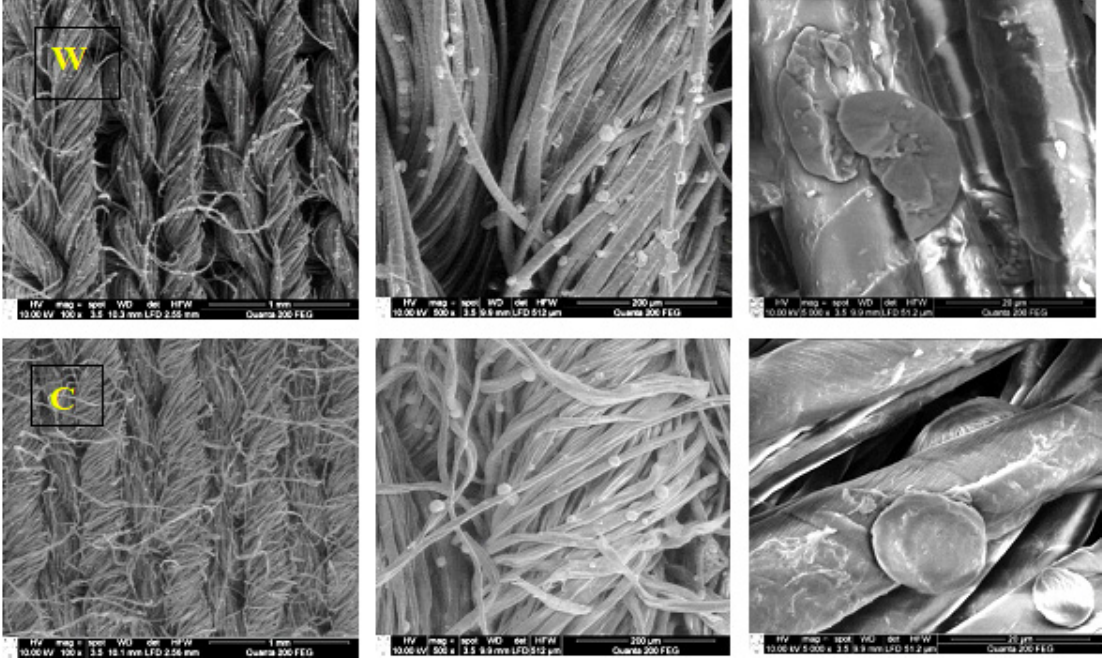
Figure 3. SEM images of W ( top ) and C ( bottom ) at 100 × , 500 × and 5,000 × magnification and particle distribution.